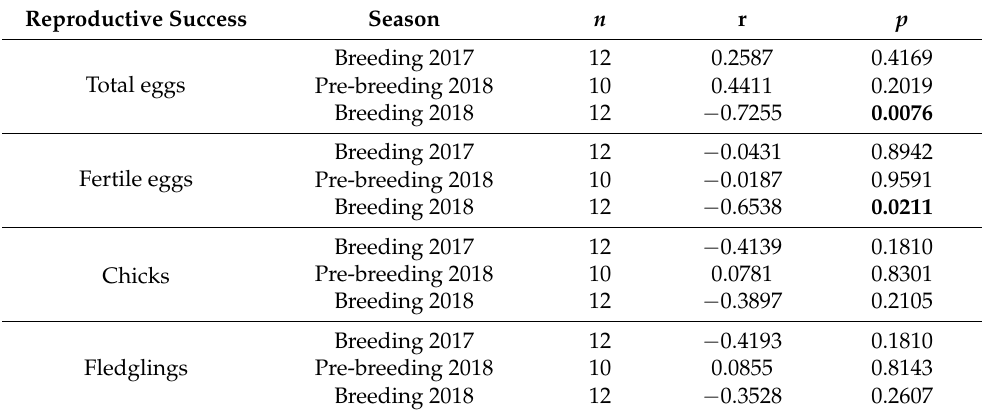
Table 1. Relationship between male fecal glucocorticoid metabolite levels and reproductive success variables